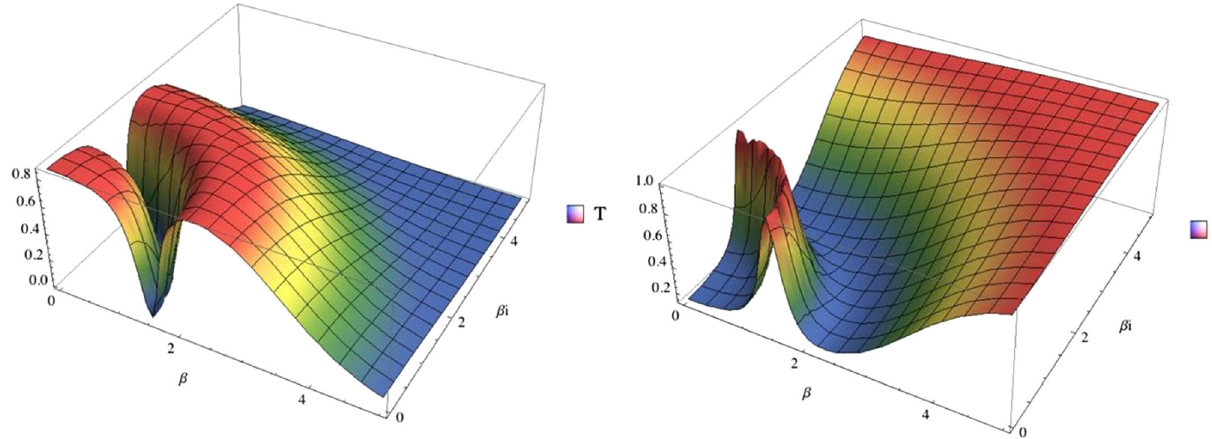
Fig. 5 Symmetrical treatments of the imaginary part of the potential for reflection and transmission coefficients